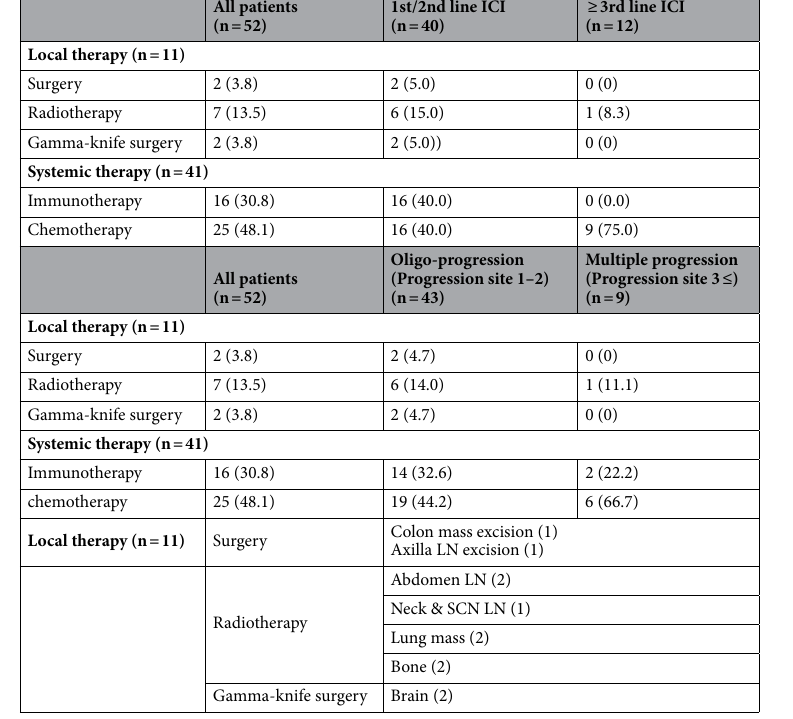
Table 4. Subsequent therapy after progression. ICI immune checkpoint inhibitors.